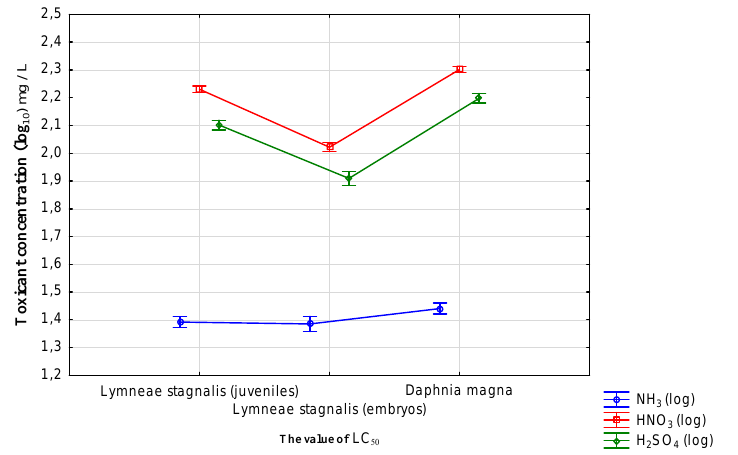
Figure 5. Comparison of LC 50 values of pollutants for selected bioindicators (standard error). Table 8. Results of one-way ANOVA.